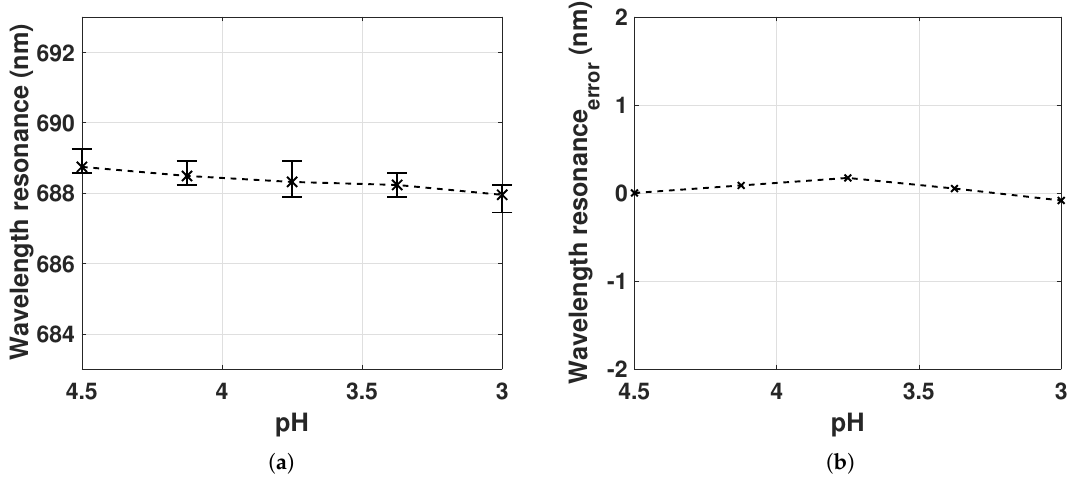
Figure 7. ( a ) LSPR peak position measured for the hydrogel deswelling from pH 4.5 to 3.0 for two sampled series with mean, minimum and maximum values from 4 sampled LSPR peak positions; ( b ) the error of the LSPR peak position by holding the reference spectrum constant at R λ ( pH 4.5 ) for pH 4.5 to 3.0. RI = 1.33 (Milli-Q